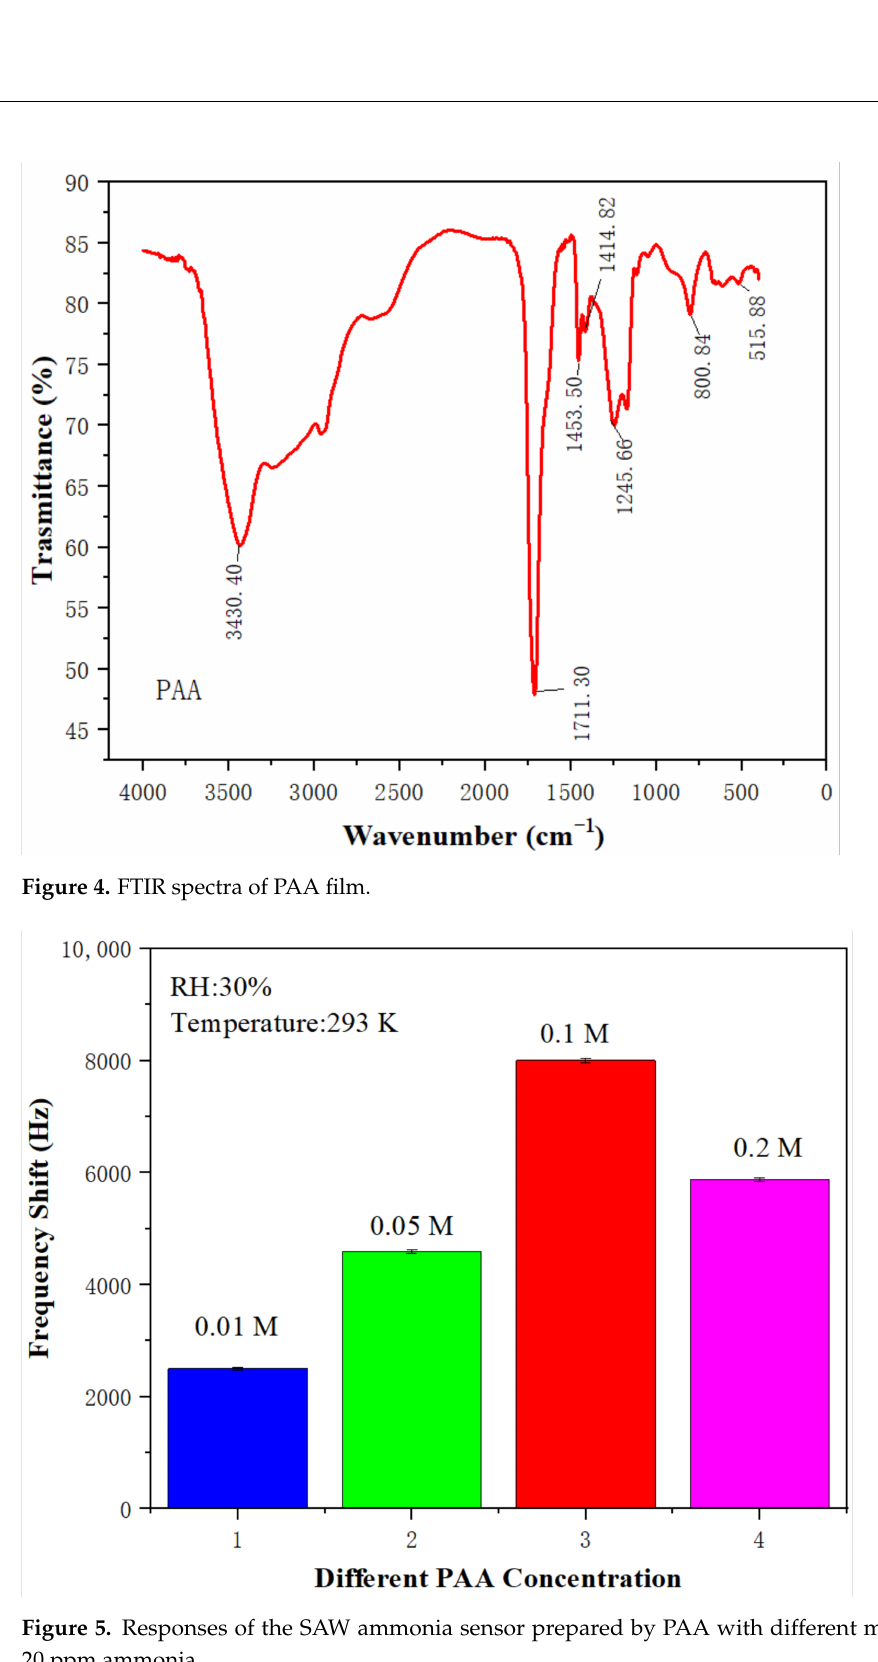
Figure 5. Responses of the SAW ammonia sensor prepared by PAA with different mole ratios to 20 ppm